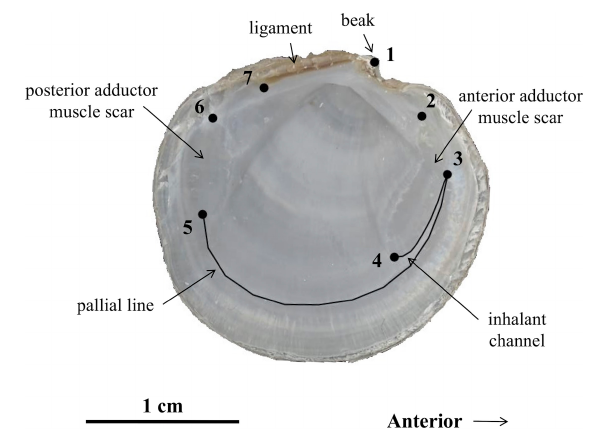
FIGURE 2 | Stewartia floridana left valve showing landmark (LM) and semi-landmark (SLM) curves used in this study. LMs are as follows, clockwise from beak: (1) beak, (2) maximum curvature of the dorsal margin of anterior adductor muscle scar, (3) intersection of the anterior adductor muscle scar and pallial line, (4) maximum curvature of the ventral margin of anterior adductor muscle scar, (5) intersection of the posterior adductor muscle scar and pallial line, (6) maximum curvature of the dorsal margin of posterior adductor muscle scar, and (7) tip of the posterior end of the ligament. SLMs include ten equidistant points, each from LMs 3 to 4 and from LMs 3 to 5, along the illustrated